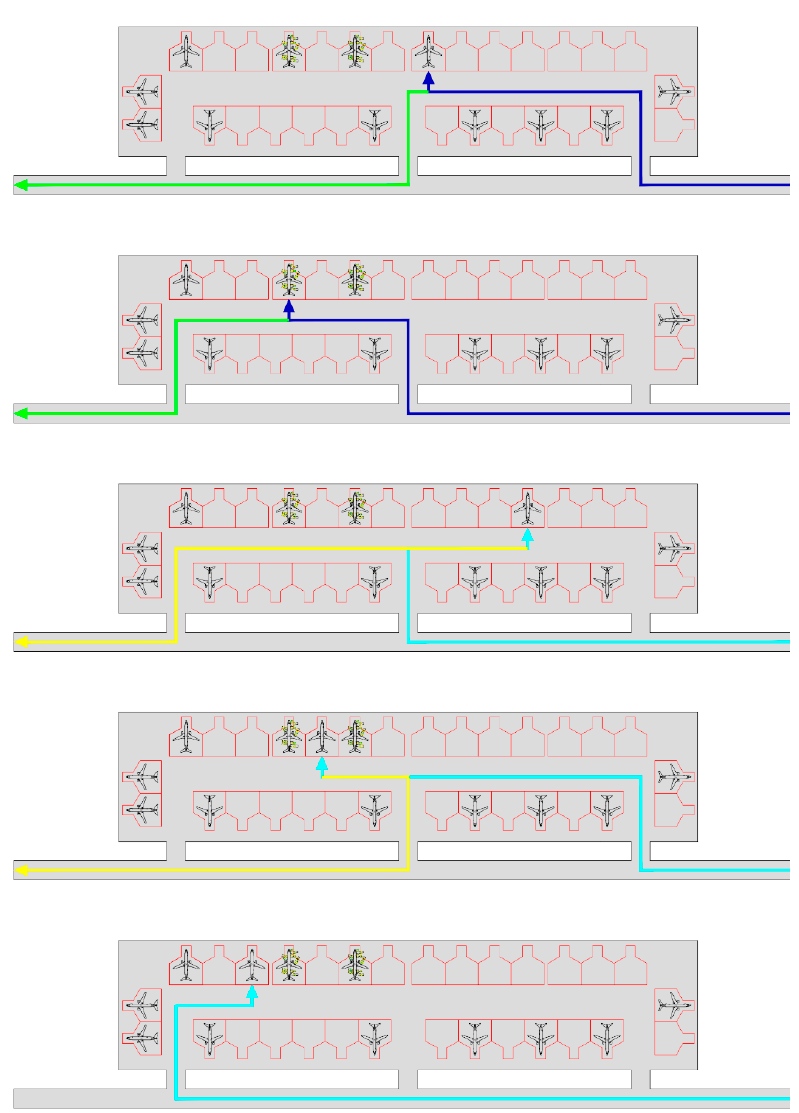
Figure A1. Apron diagram, main traffic direction.